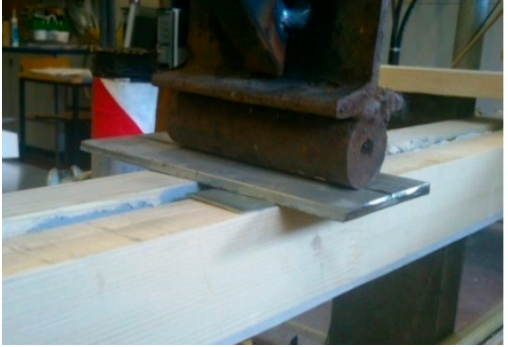
Figure 16. Steel plates to prevent the weight yoke from pushing into the timber.